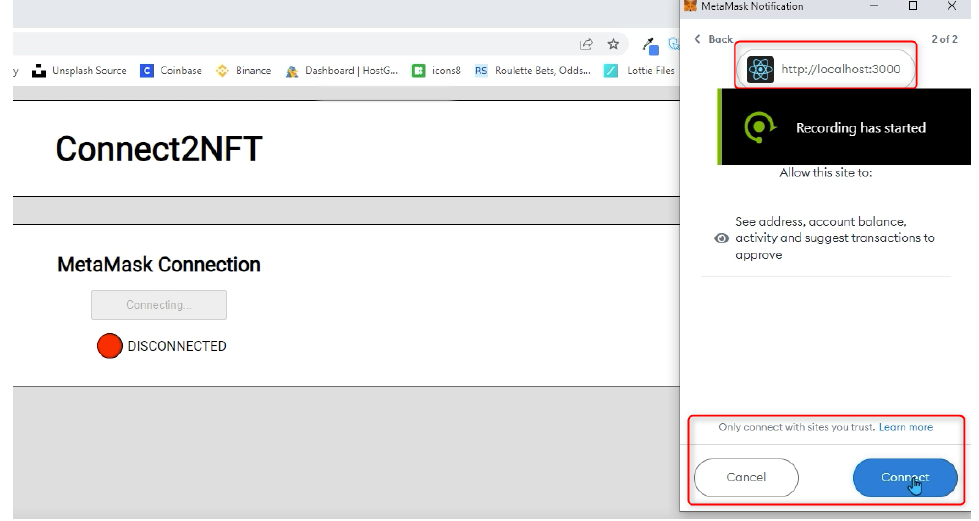
Figure 1. Connection attempt to MetaMask wallet.